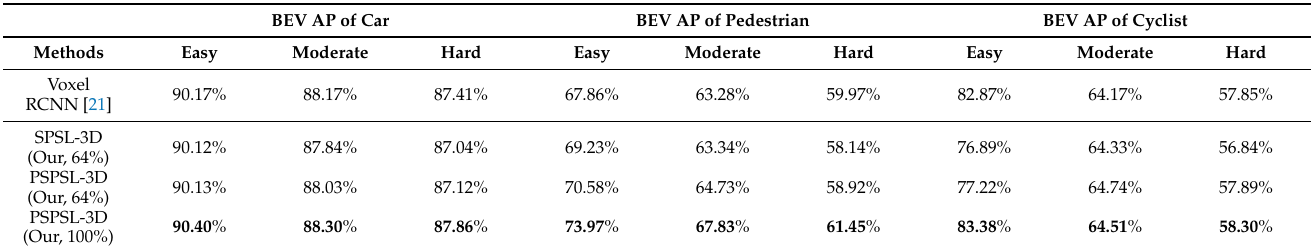
Table 7. BEV AP of the proposed SSOD-3D at R anno = 64% and baseline FSOD-3D methods in KITTI validation dataset.